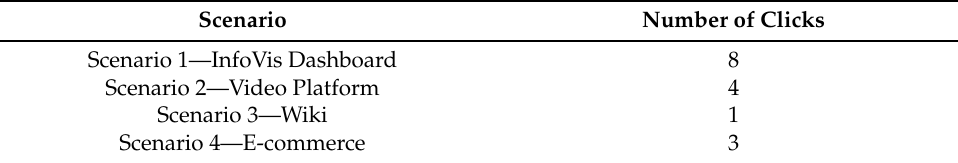
Table 4. Minimum number of clicks to complete each task.